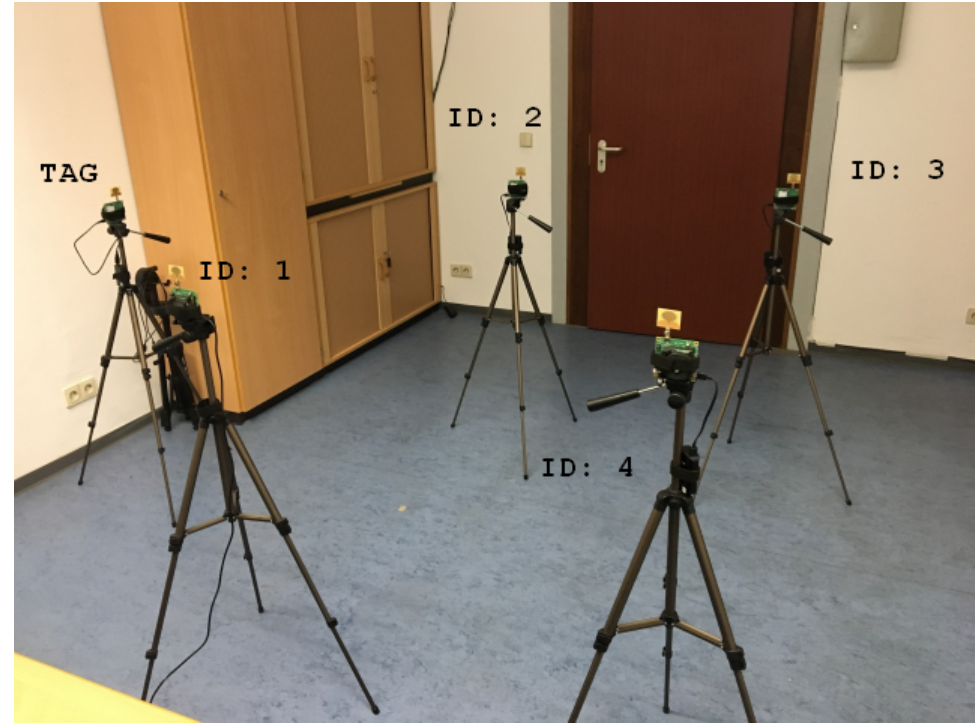
Figure 3. Experimental setup with the DecaWave UWB. The four UWB base stations with ID 1 to 4 are mounted on a tripod. The tag is located on the left side in the picture.